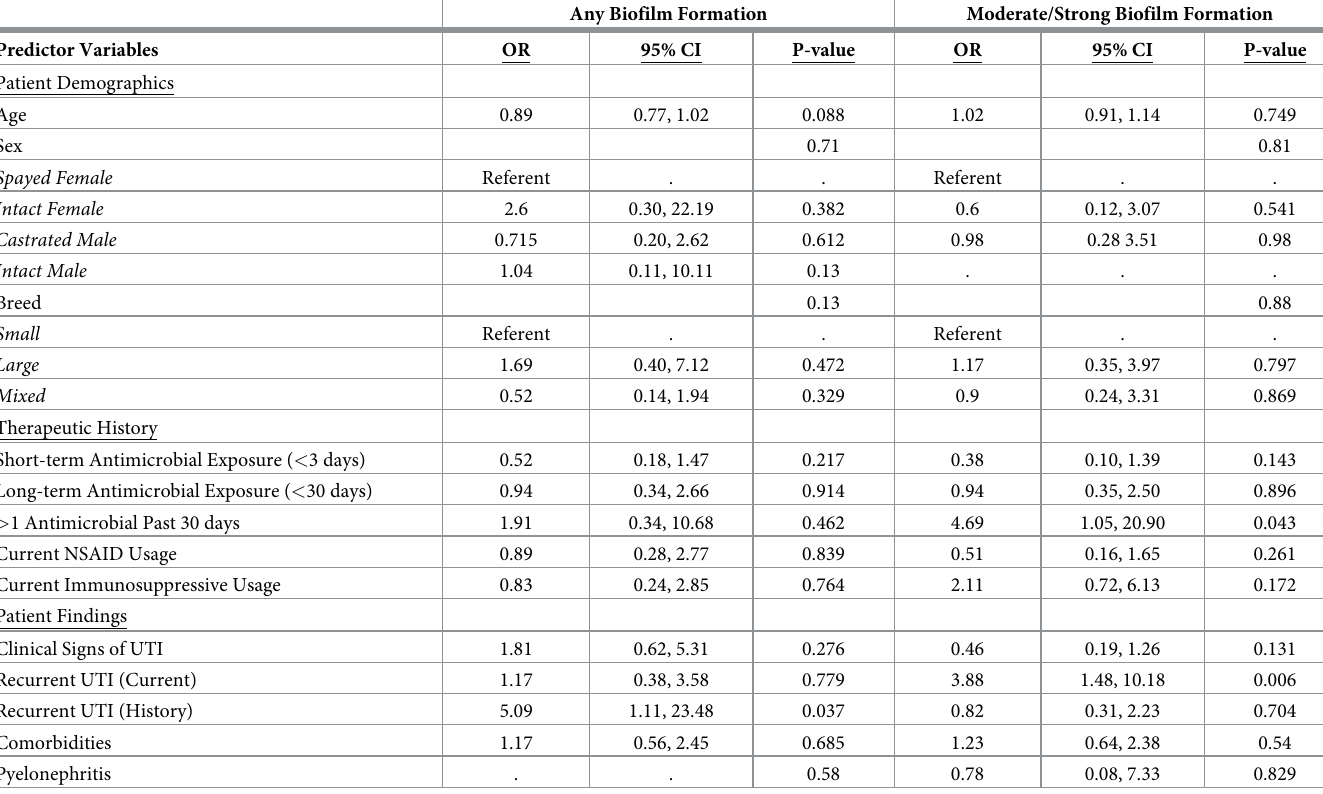
Table 1. Univariate logistic regression analysis of patient factors and biofilm